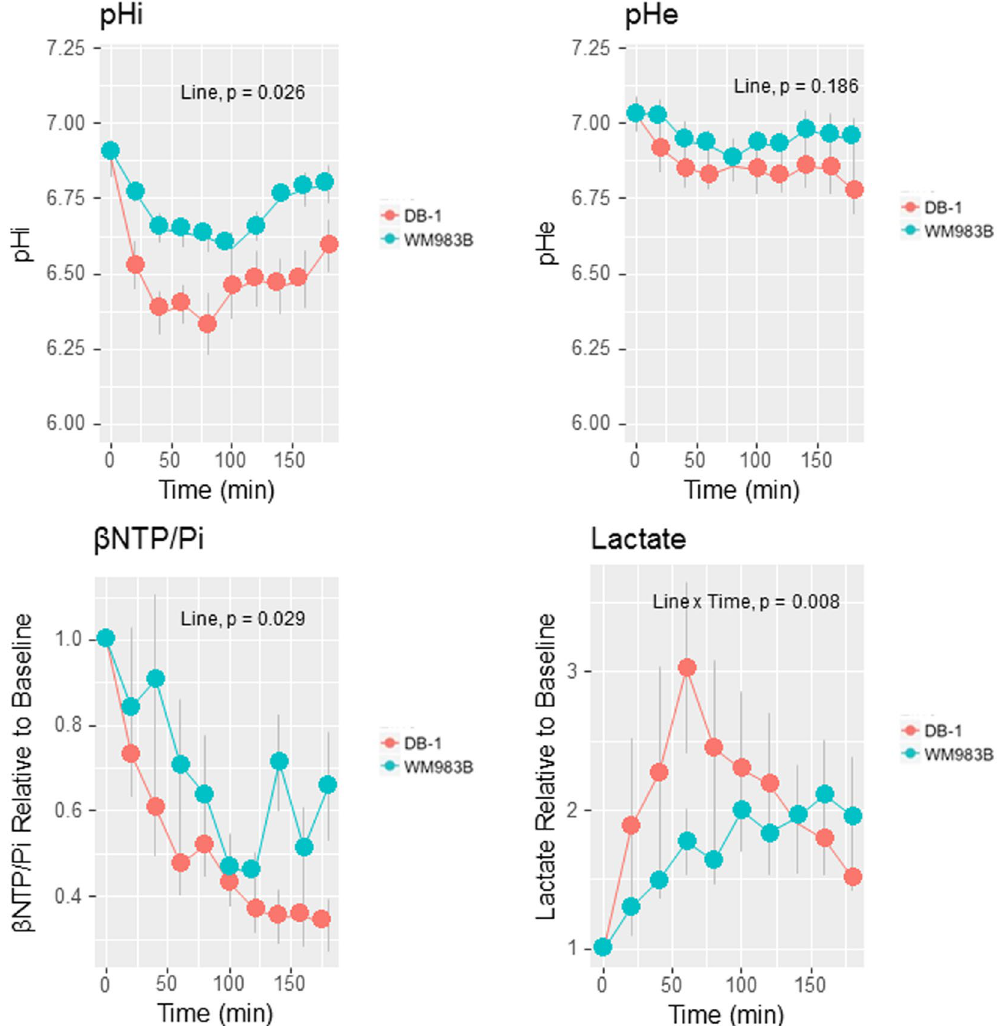
Figure 5. Lonidamine (LND) causes simultaneous acidification and de-energization of WM983B human melanoma xenografts. For comparison, we include previously published results for DB-1 xenografts 12 Intracellular pH (pHi) differed by melanoma line (p = 0.036, F 1,20 ) while no differences between cell lines were detected for pHe. Bioenergetics (ratio of β -nucleoside triphosphate to inorganic phosphate ( β -NTP/Pi) differed by tumor line (p = 0.029, F 1,20 ) while lactate showed differential effects by tumor as a function of time (p = 0.008, F 1,48 ) (d) shows tumor lactate relative to baseline (n = 5). Data shown as mean ±